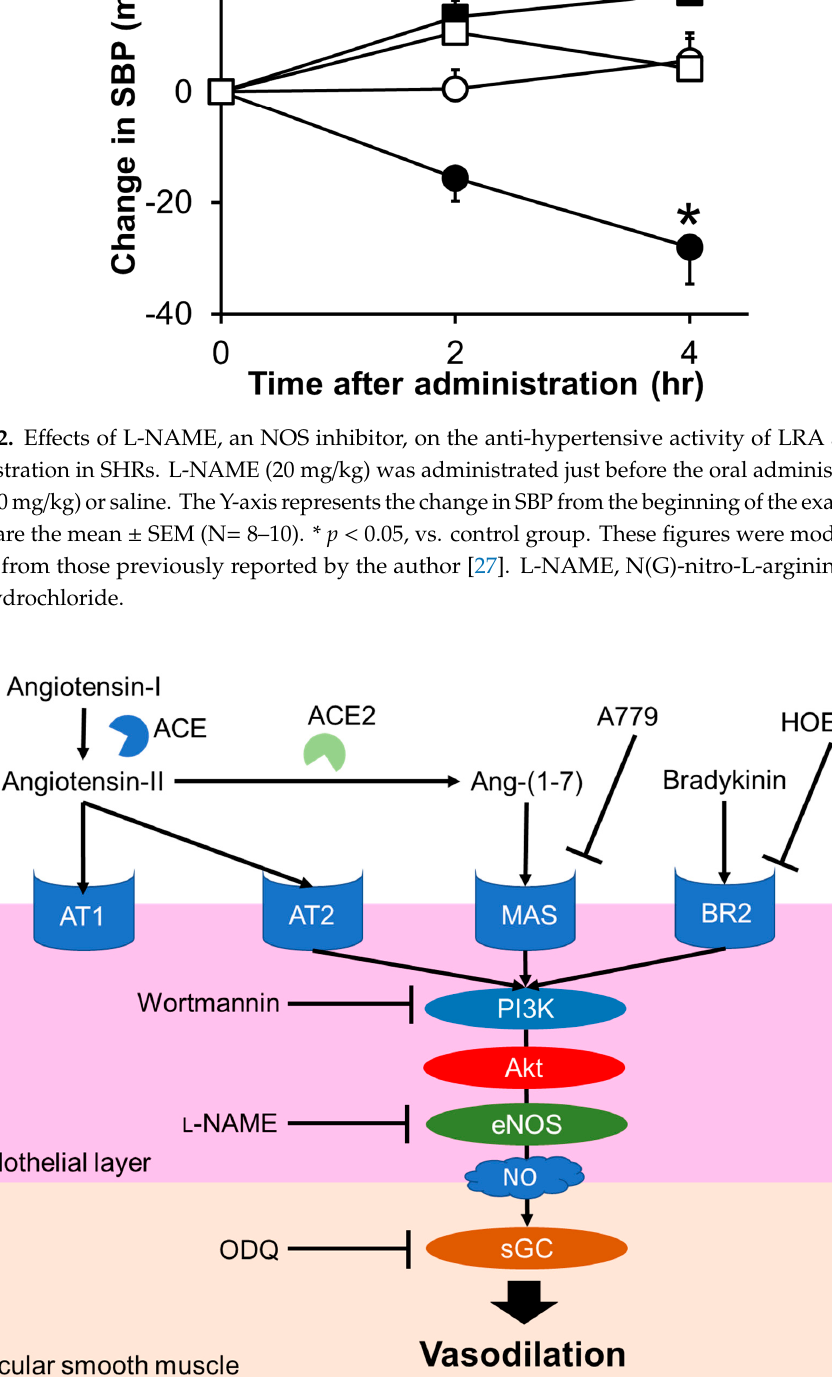
Figure 4. Predicted cleavage site of LRA from vicilin-like storage protein. These figures were modified and quoted from those previously reported by the author [26]. 2.2. Tyr-Tyr Tyr-Tyr (YY) was also identified from thermolysin-digested rice bran as an anti-hypertensive peptide [26]; orally administered YY reduced the blood pressure at 0.5 mg/kg in SHRs (Figure 5A). Its high ACE inhibitory activity was also confirmed by an IC 50 = 16 μ M. ACE is in a membrane-bound form in endothelial cells, neuroepithelial cells and the brain [35]. A soluble form was also reported, and is present in blood and different body fluids. ACE is a dipeptidyl carboxypeptidase that catalyzes the conversion of angiotensin I (Asp-Arg-Val-Tyr-Ile-His- Pro-Phe-His-Leu) to His-Leu and angiotensin II (Asp-Arg-Val-Tyr-Ile-His-Pro-Phe), a vasopressor peptide hormone [36]. ACE inhibitors reduce blood pressure by inhibiting ACE. ACE inhibition is a major mechanism of anti-hypertensive peptides derived from food-derived proteins. YY was also